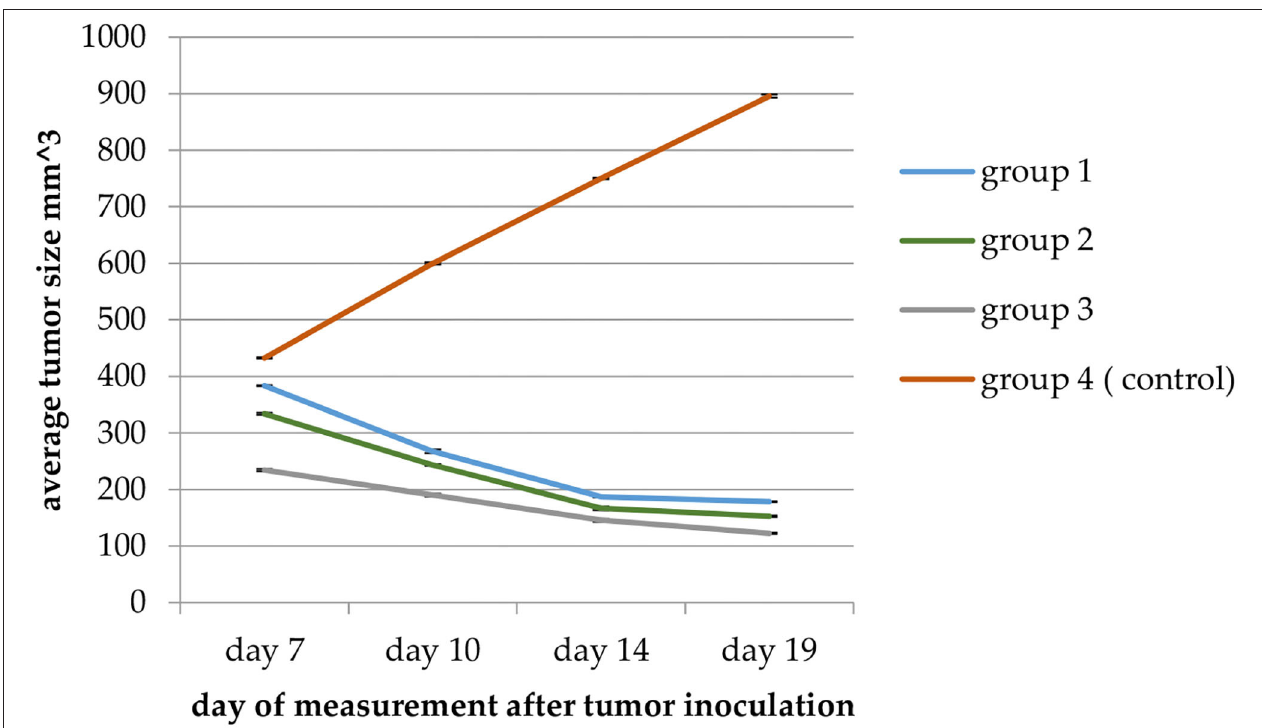
FIGURE 6 | A plot of change in average tumor size (mm 3 ) vs. time in (days) of measurement in the EMT6/P cell line. Average tumor size in Group 3 (mice given fodders with 30% barley bran) was significantly ( p < 0.05) reduced compared with the control